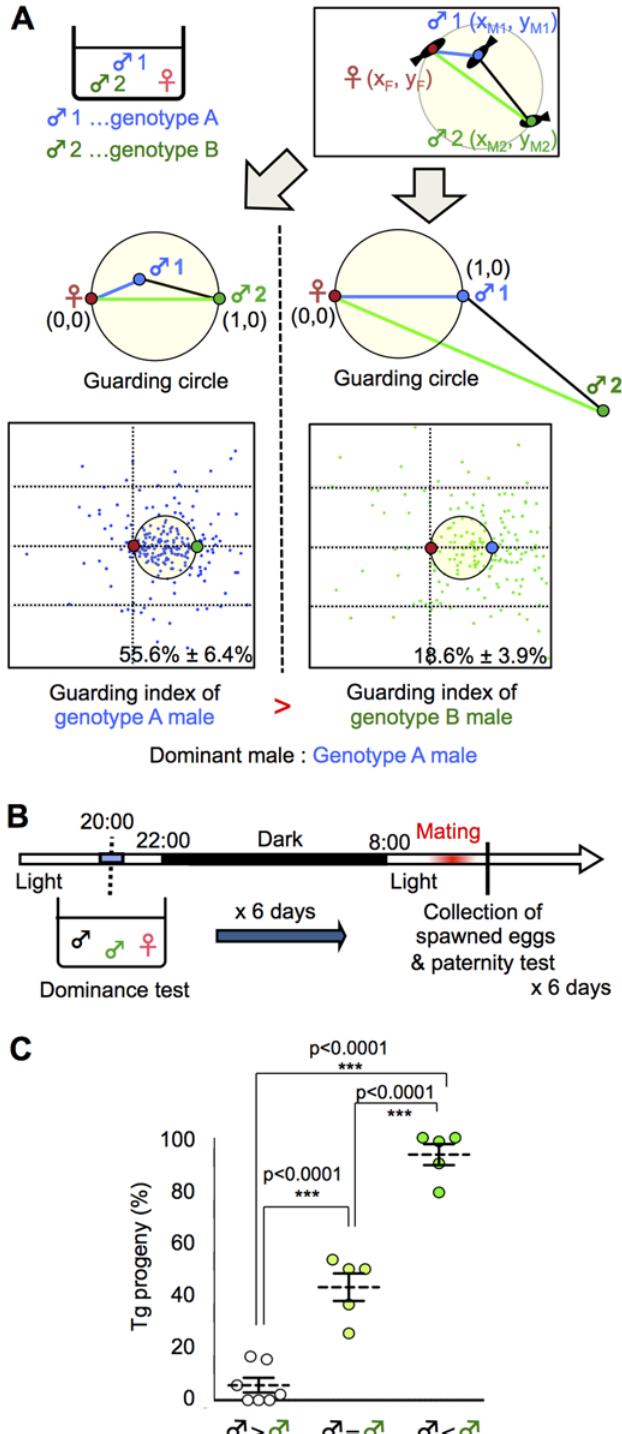
Fig 2. Dominance of mate-guarding in a triadic relationship. (A) Comparison of the dominance in mate- guarding behavior (dominance test). We used one genotype A male and one genotype B male and measured their mate-guarding behavior when exposed to a female. We measured the relative locations of the three fish and calculated the probability of the genotype A male being in the guarding circle when the female and genotype B male positions were defined as (0, 0) and (1, 0), respectively (Left). We defined this probability